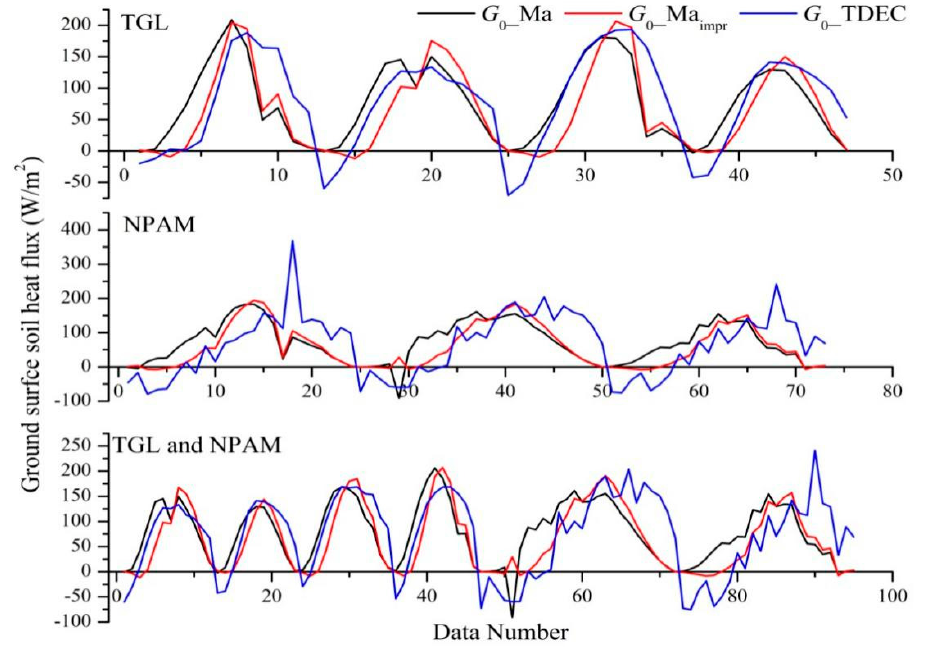
Figure 14. Comparison between the Ma impr and Ma schemes at each site